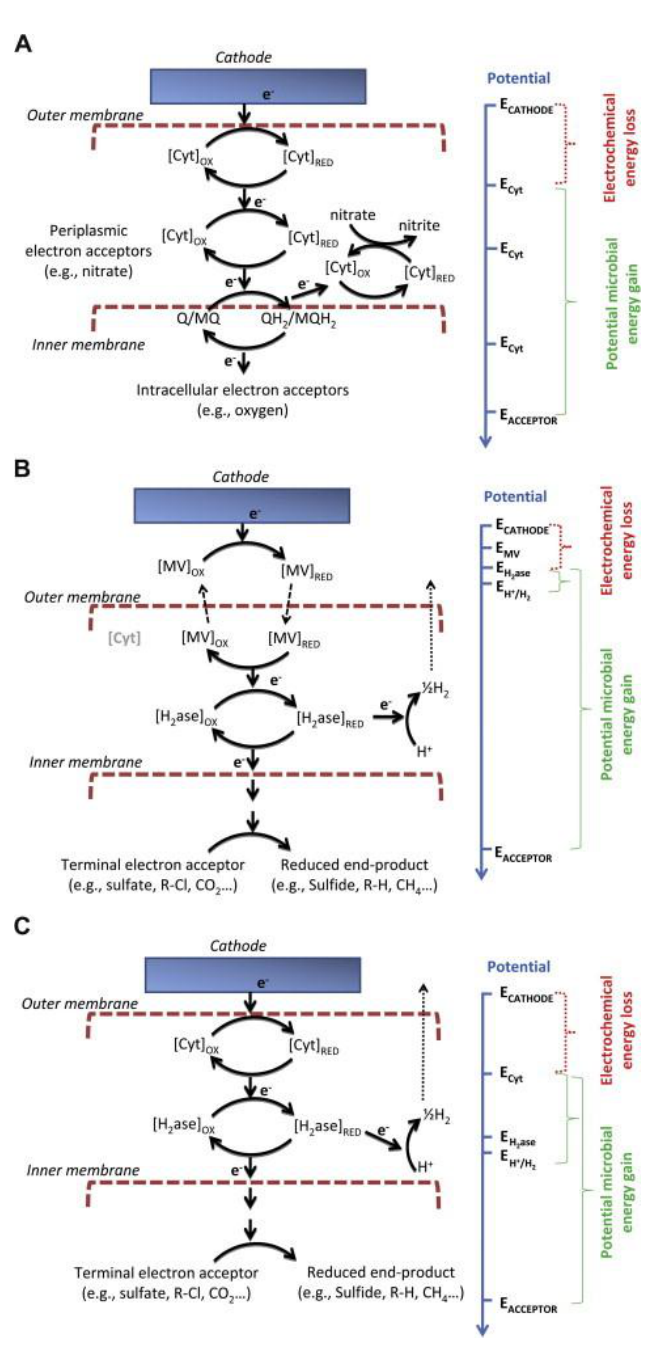
Figure 7. Proposed mechanism for hydrogen production and energy conservation coupled to proton translocation in microbial cells at the biocathode. Legend: Ech = energy-conserving hydrogenase; hyd = hydrogenase. ( A ) Direct electron transfer involving cytochrome-hydrogenase partnerships; ( B ) Indirect electron transfer with external redox mediator; ( C ) Direct electron transfer with internal redox mediator. In the three mechanisms the potential microbial energy as well as the electrochemical energy loss is different